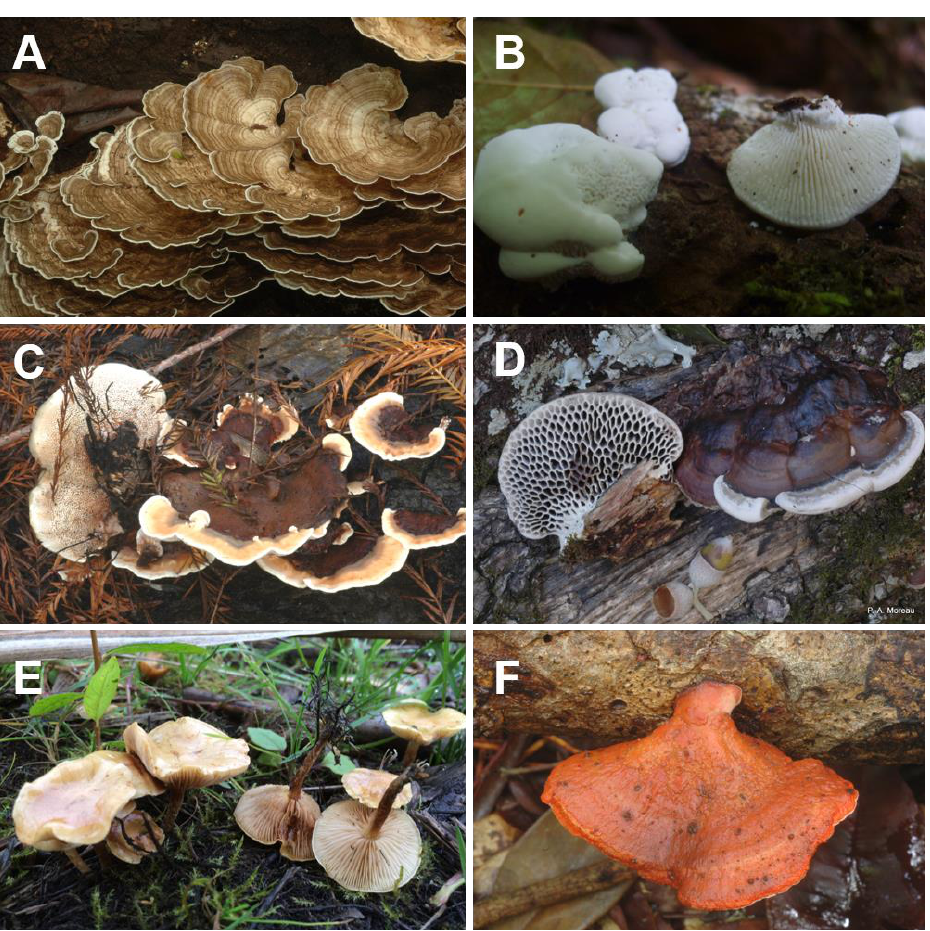
Figure 3. Examples of Polyporales fungi. ( A ) Leiotrametes menziesii , ( B ) Artolenzites elegans , ( C )